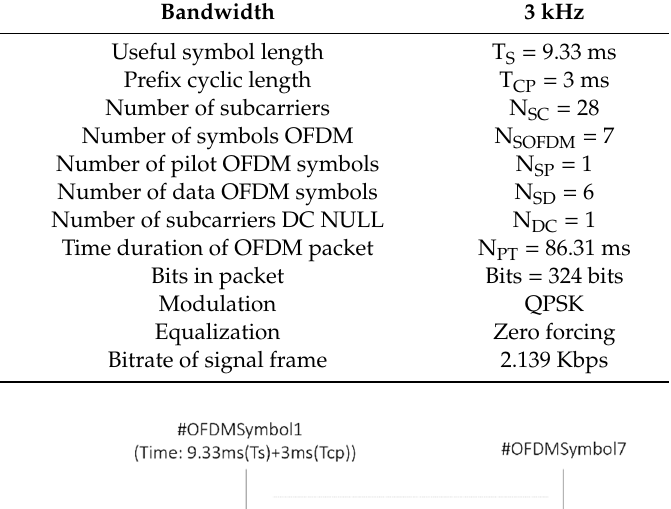
Table 2. OFDM configuration for NVIS transmission.